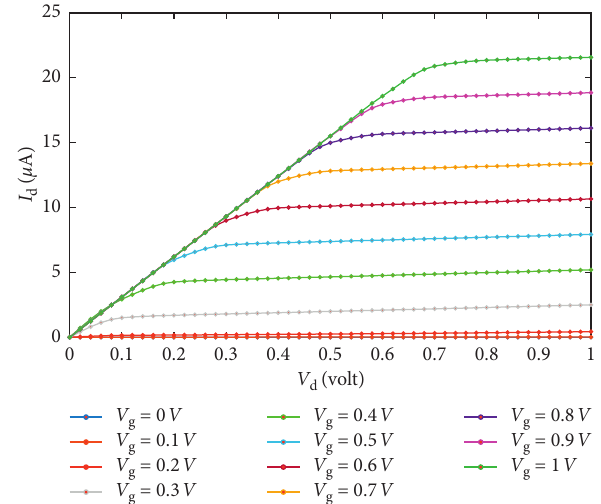
Figure 3: I d – V d characteristics of n-type GNRFETs for multiple gate voltages in 0.1V decrement from V g � 1 V at the top.